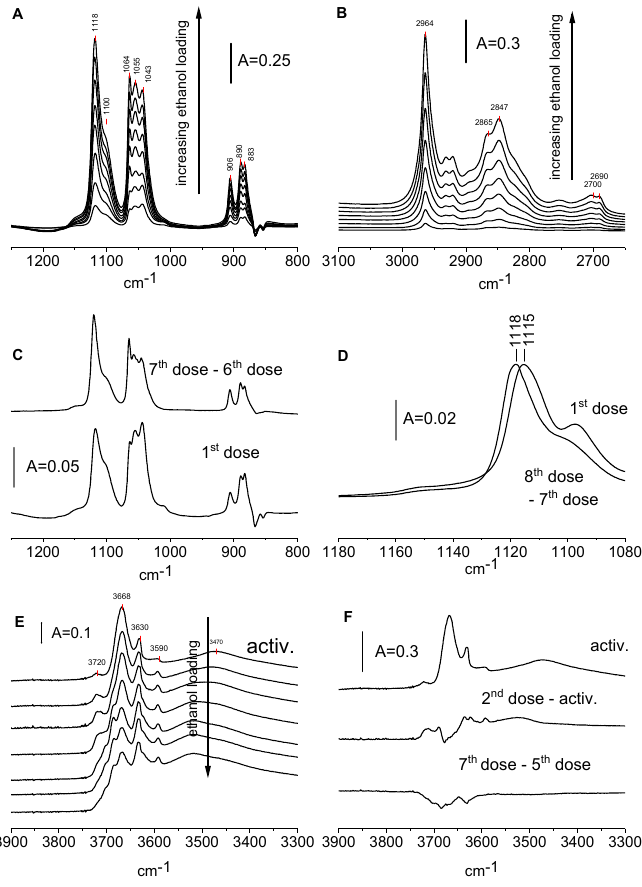
Figure 5. ( A , B )—The spectra of ethoxy groups on CeO 2 formed upon the adsorption of ethanol. Figure 5. A, B - The spectra of ethoxy groups on CeO 2 formed upon the adsorption of ethanol. C, D ( C , D )—The spectra of ethoxy groups on CeO 2 formed by the adsorption of the 1st dose of ethanol and – The spectra of ethoxy groups on CeO 2 formed by the adsorption of 1 st dose of ethanol and dif- ference spectra (8 th dose minus 7 th dose). E – The spectra of OH groups on CeO 2 and spectra rec- difference spectra (8th dose minus 7th dose). ( E )—The spectra of OH groups on CeO 2 and spectra orded upon the adsorption of ethanol. F – The spectrum of OH groups on CeO 2 and difference recorded upon the adsorption of ethanol. ( F )—The spectrum of OH groups on CeO 2 and difference spectra: second dose minus activated sample and sevenths dose minus fifths dose. spectra: second dose minus activated sample and seventh dose minus fifth dose. Table 1. The frequencies of monodentate, bidentate, and tridentate ethoxy groups. Monodentate Bidentate Tridentate sym. C-C-O 906 890 883 asym. C-C-O 1064 1055 1043 combination 1118 a a a—cannot be measured because of band overlapping. Table 2. The frequencies of C-C-O asymmetric bands of ethoxy groups formed of non-reduced, reduced and oxidized CeO 2 . Monodentate Bidentate Tridentate oxidized 1064 1051 1040 non reduced 1064 1055 1043 mildly reduced a 1058 1048 deeply reduced a a 1058 a—band